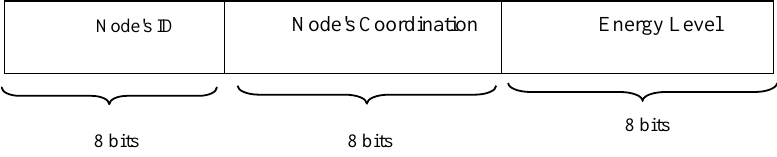
Figure 1. Structure of HELLO message.